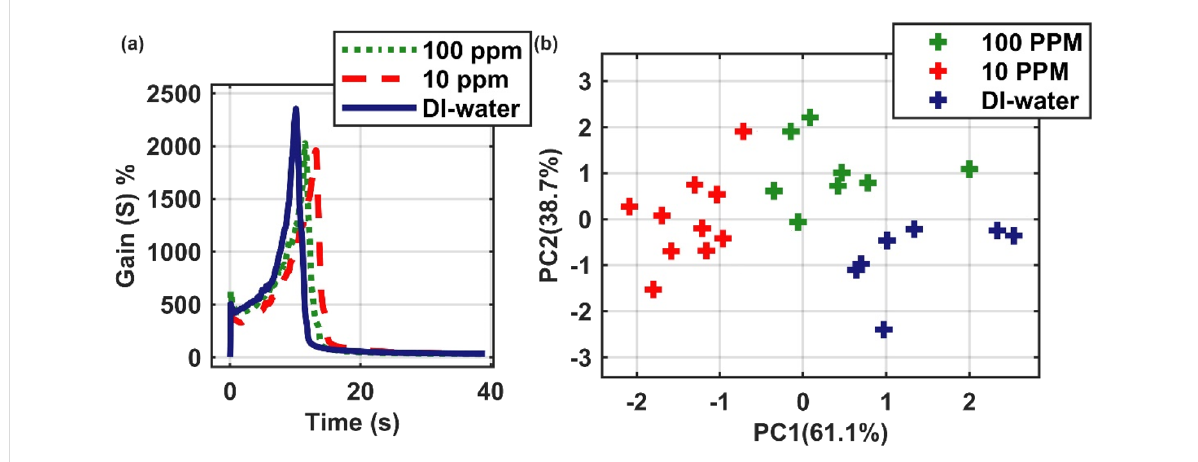
Figure 2: (a) Gain curves obtained from different glycerin/water mixtures; each point at the PCA diagram (Figure 2b) was calculated from a single measurement. (b) PCA analysis of DI water, 10 ppm and 100 ppm glycerin/water